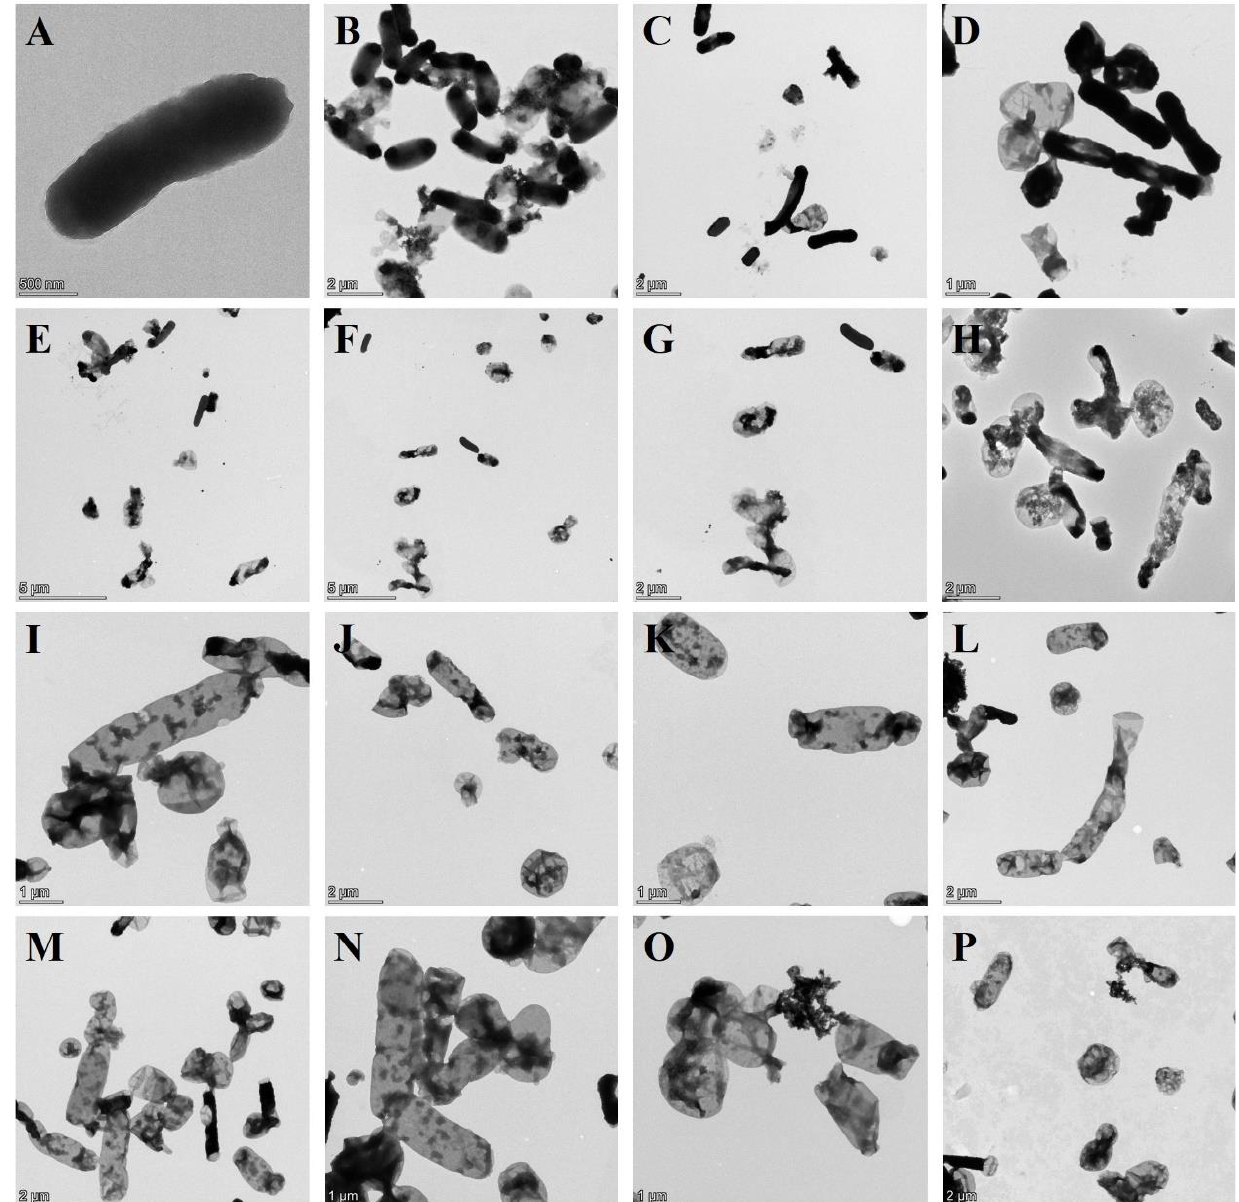
Figure 4. Morphological Observation of E. coli BL21(DE3) BGs by TEM. ( A ): Intact morphology of wild-type E. coli BL21(DE3); ( B – D ): E. coli BL21(DE3) ghost formed after lysis induced by plasmid pBV220- φX174 -E; ( E – H ): E. coli BL21(DE3) ghost formed after lysis induced by plasmid pBV220-ID52-E; ( I – P ): E. coli BL21(DE3) ghost formed after lysis induced by plasmid araC-ParaBAD-ID52-